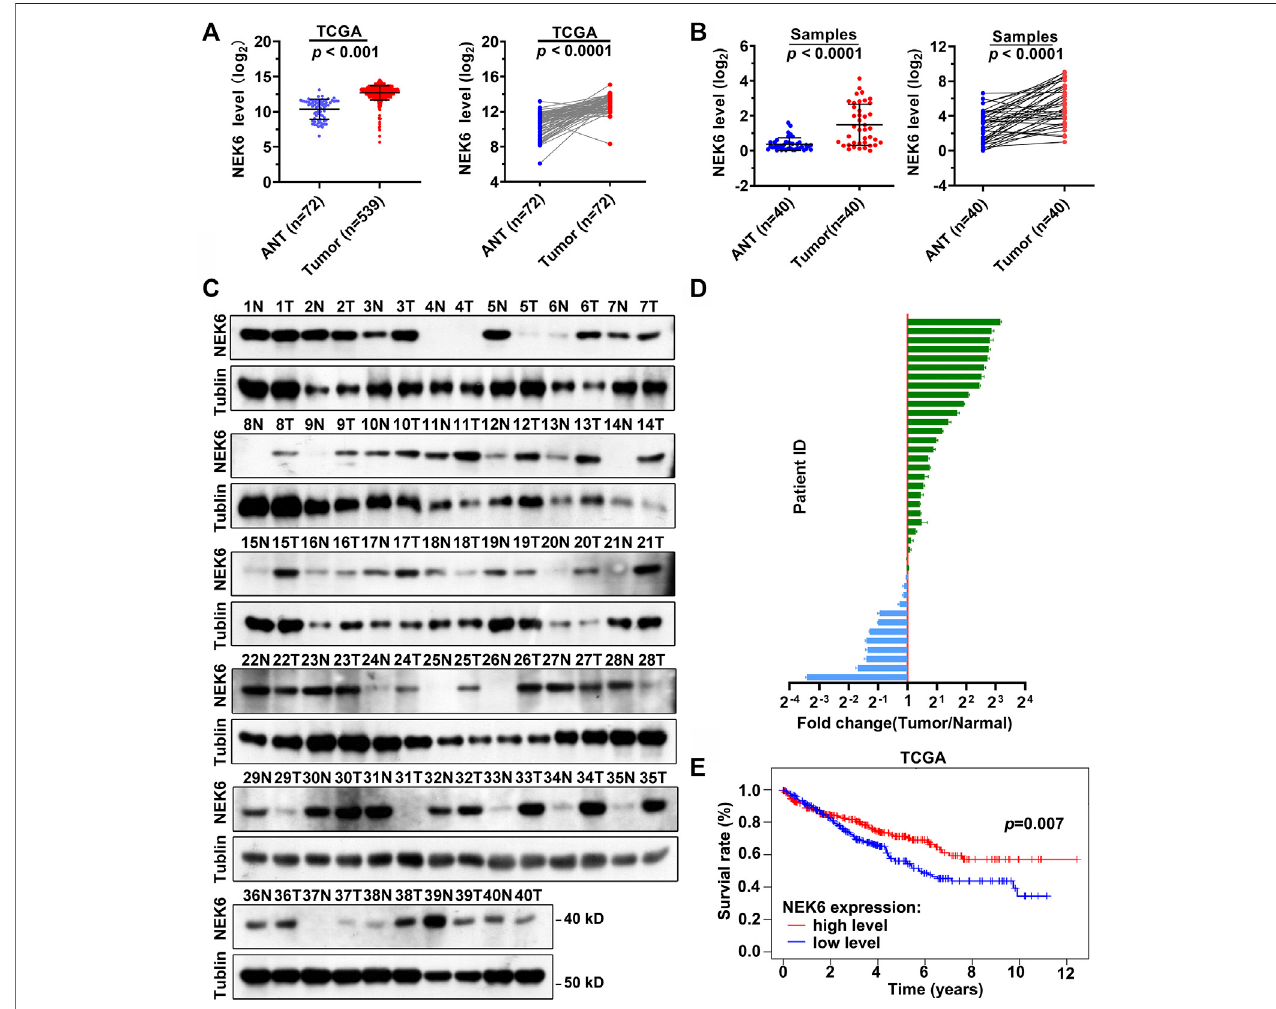
FIGURE 6 | Elevated expression level ofNEK6 in RCC. (A) Scatter plots showing the expression of NEK6 in RCC ( n = 539) and normal tissues ( n = 72) from TCGA cohort. (B) ScatterplotsshowingtheexpressionlevelsofNEK6inRCC( n =40)andnormaltissues( n =40)fromourcohort. (C,D) Blottingimages (C) andquanti fi cation (D) ofproteinlevelofNEK6inRCCandnormaltissuesfromourcohort. (E) Kaplan-MeieranalysisoftheoverallsurvivalrateofRCCpatientsstrati fi edbytheexpressionof NEK6 from TCGA